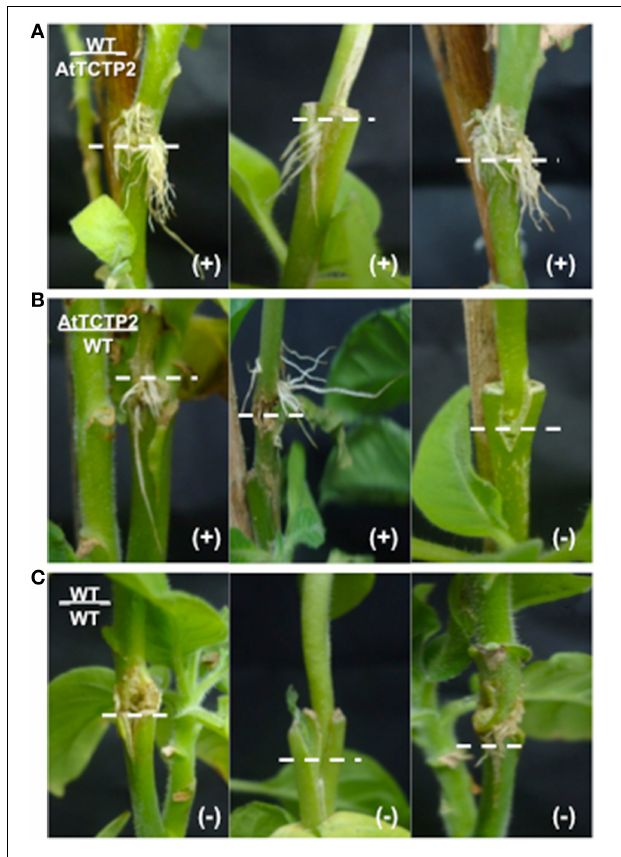
FIGURE 5 | Emergence of adventitious roots associated to long-distance movement of AtTCTP2. Representative images were taken previous tissue collection for RT-PCR and confocal analysis (30 days). (A) WT/AtTCTP2 grafts presented aerial roots in all samples, which is consistent with the protein detection in the same graft samples (see Table 1 ). ( B : left and middle) AtTCTP2/WT grafts produced aerial roots in four out of seven trials, correlating specifically to the presence of AtTCTP2-GFP protein in the same graft samples (see Table 1 and Figure 2 ). ( B : right) Hence, in the samples where no aerial roots were present no protein was observed. (C) The latter is consistent to the WT/WT graft